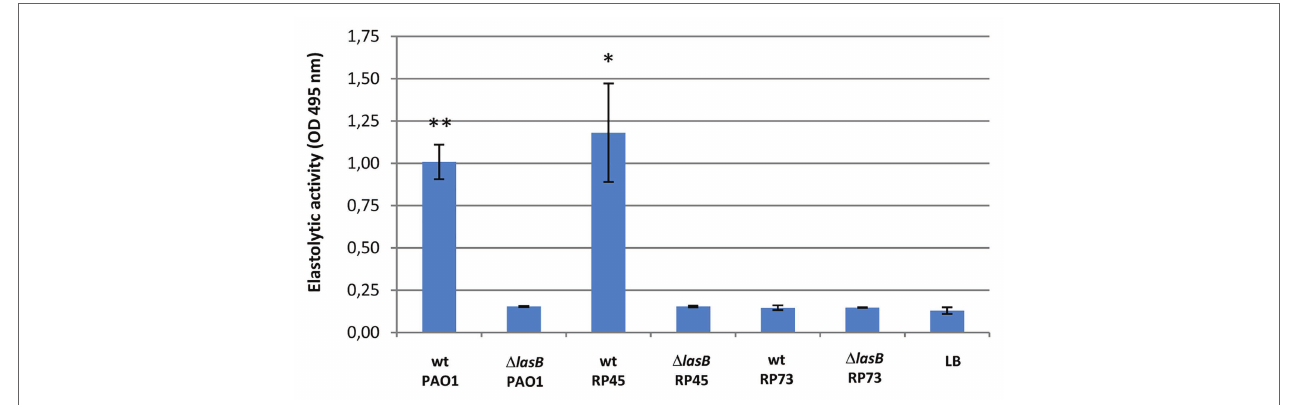
FIGURE 1 | LasB elastolytic activity in culture supernatants from Pseudomonas aeruginosa PAO1 and cystic fibrosis (CF) isolates RP45 and RP73 [wild-type (wt) vs. ∆ lasB mutants]. LasB activity in bacterial supernatants (prepared by centrifugation and filtration after 24 h of growth and diluted to 1:10) was evaluated by Elastolytic assay (ECR method, after 20 h of incubation with ECR substrate). Luria-Bertani (LB) growth medium was used as negative control. The data were pooled from two independent experiments in quadruplicate ( n = 8 per strain). Statistical significance is indicated as follows: * p < 0.05; ** p <